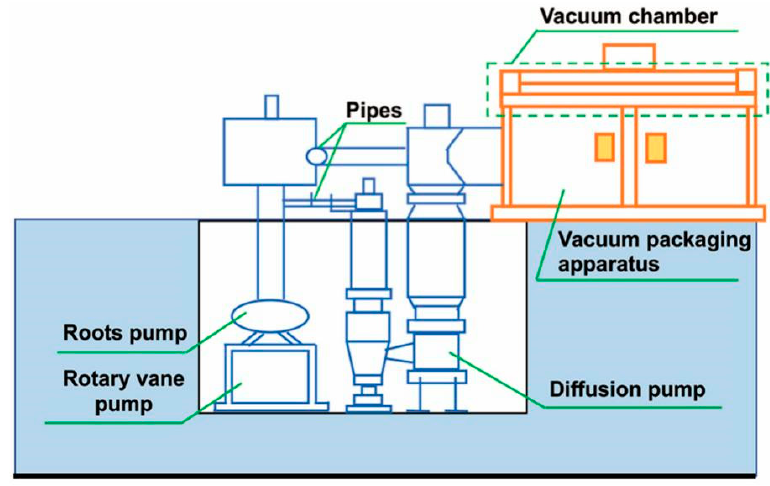
Figure 2. Schematic drawing of vacuum equipment [14].